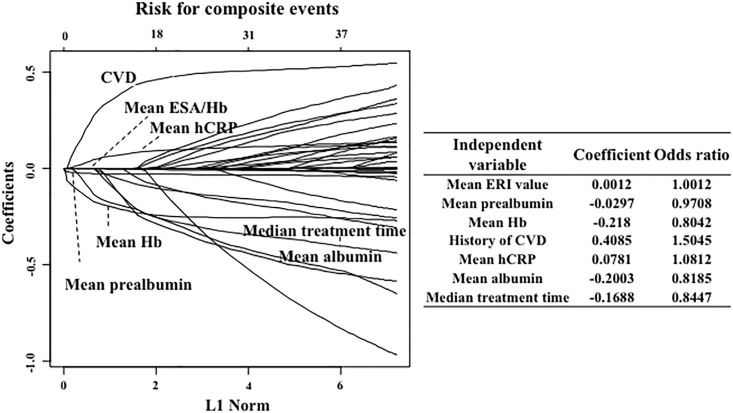
Correlation between mean or median levels of parameters and composite events.In the LASSO analysis, the mean ERI during the study period, lower mean prealbumin levels (odds ratio, 0.9708), lower mean Hb levels, history of CVD, higher mean hCRP levels, lower mean albumin levels, and shorter median treatment time were predictors of composite events in maintenance hemodialysis.